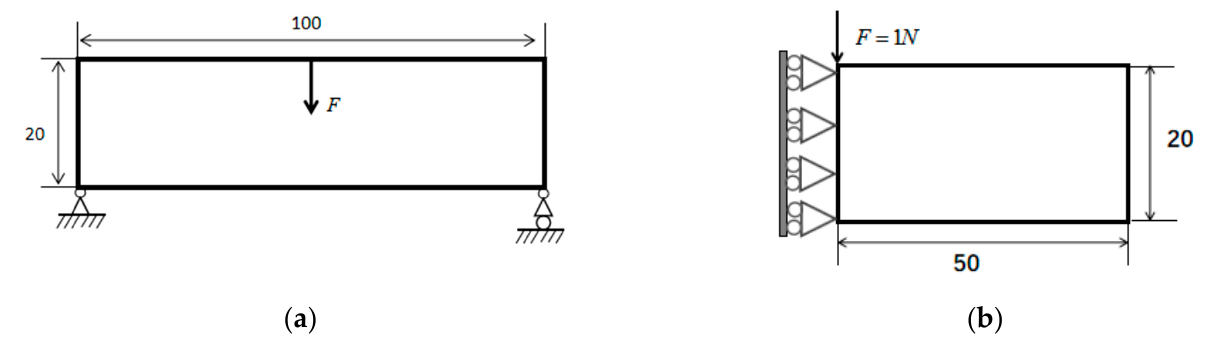
Figure 2. Design domain of a Michell-type structure: ( a ) two-dimensional simply supported beam; ( b ) the design area of the right half of the beam.